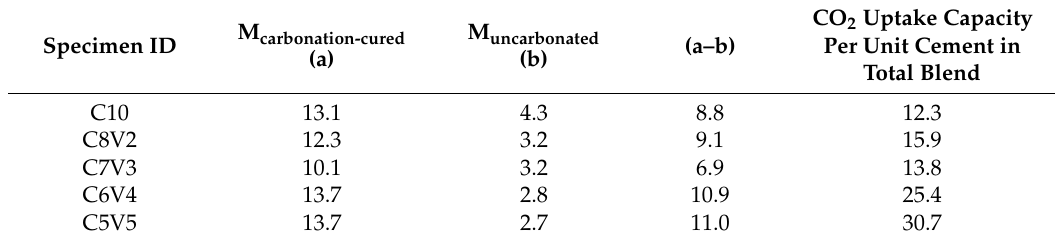
Table 5. CO 2 uptake capacity of carbonation-cured volcanic ash-blended cement calculated from thermogravimetry results